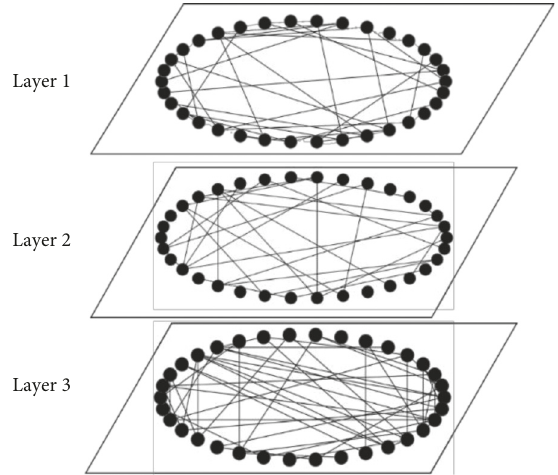
Figure 7: The innovation value transformation network: the first layer is the investment network, the second layer is the patent network, and the third layer is the production network.